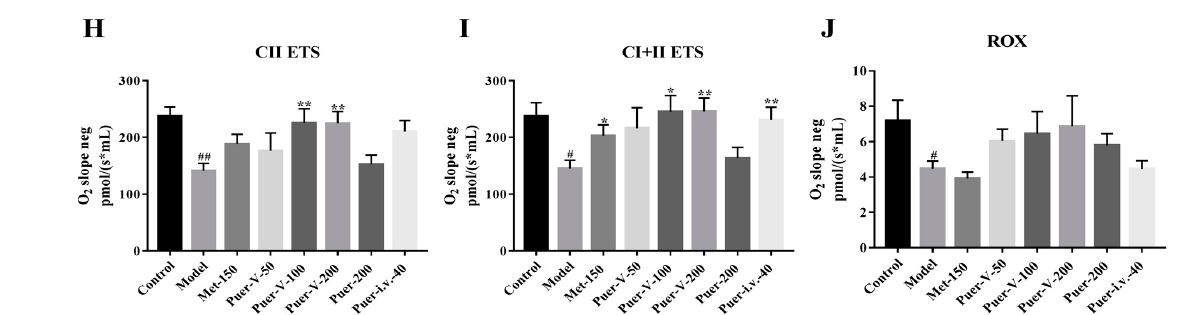
Figure 10. Puerarin-V increased mitochondrial respiration in hearts of DCM rats through complex I/II-related molecular mechanisms. ( A ) The situation of cabin. ( B ) The protocol. Summary of mitochondrial respiration data in different groups, including routine measurements ( C ), CI leak ( D ), CI oxidative phosphorylation ( E ), CI plus CII oxidative phosphorylation ( F ), outer mitochondrial membrane integrity ( G ), CII electron transfer system ( H ), CI plus CII electron transfer system ( I ), residual non-mitochondrial oxygen consumption ( J ). The data are represented by mean ± SEM (n = 6–8). # p < 0.05 and ## p < 0.01 vs. control group. * p < 0.05 and ** p < 0.01 vs. model